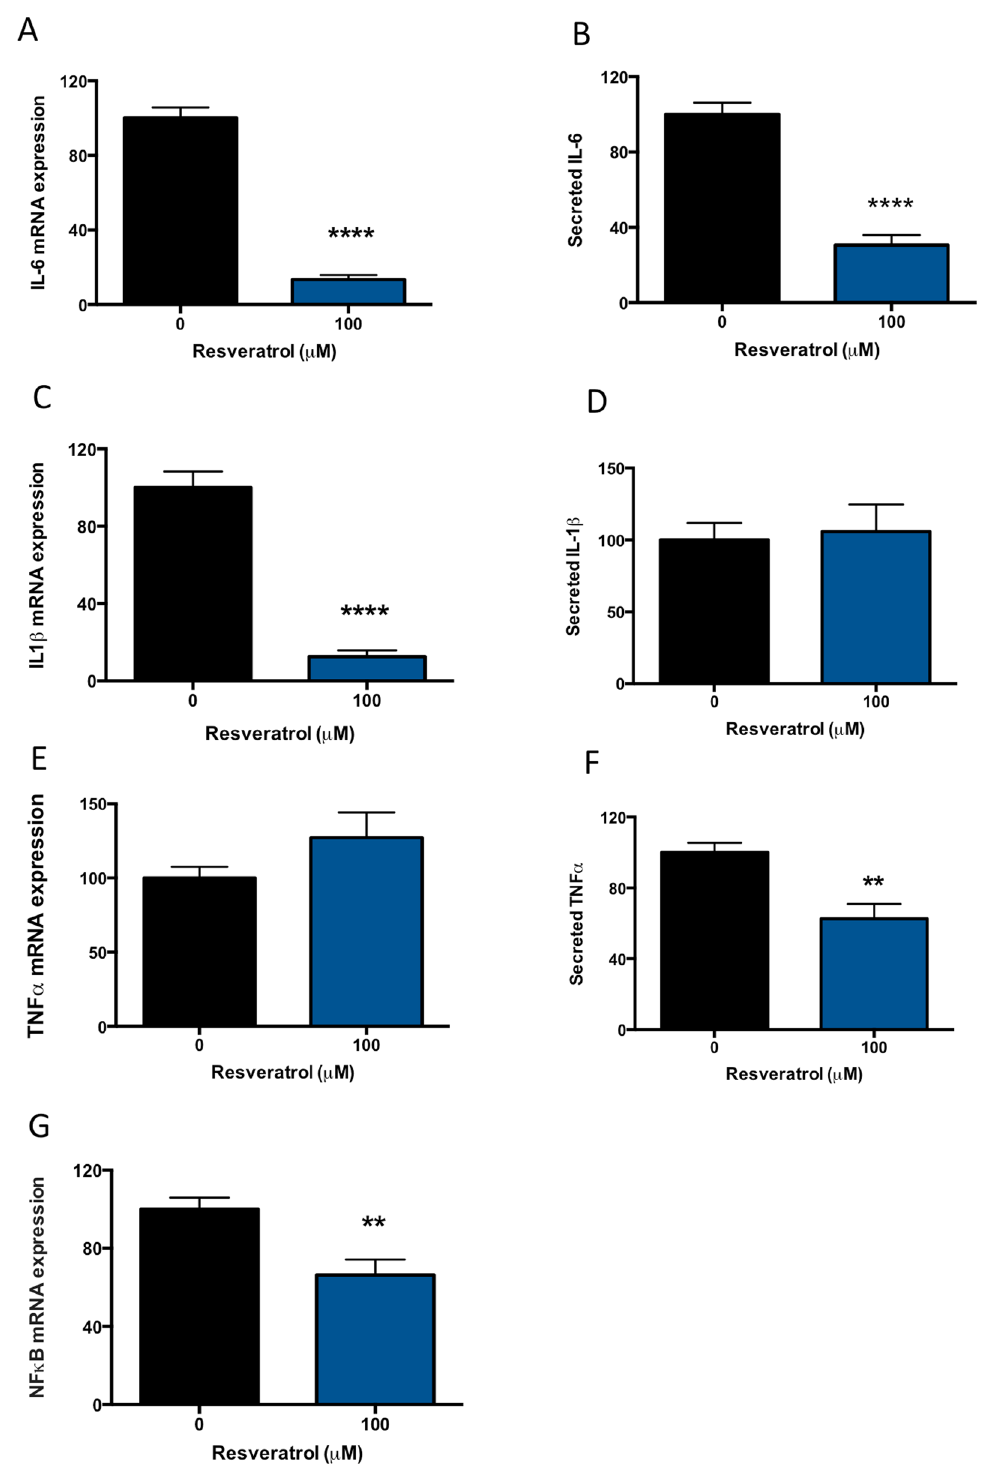
Figure 4. Resveratrol inhibits inflammatory molecules in primary cytotrophoblast. Preeclampsia is a condition associated with significant inflammation. Therefore we assessed the ability for resveratrol to reduce pro- inflammatory cytokine mRNA expression and secretion. In primary trophoblast, we found that resveratrol significantly reduced ( A ) IL-6 mRNA and ( B ) protein secretion. Whilst resveratrol significantly reduced ( C ) IL-1 β mRNA expression, there was no significant effect on IL-1 β secretion ( D ). TNF α mRNA expression was not altered by resveratrol ( E ), however secreted TNF α was significantly reduced ( F ). Finally a significant reduction in ( G) NF κ B mRNA expression was also significantly reduced. Data expressed as mean ± SEM. ** p < 0.01, **** p < 0.0001 compared to 0 resveratrol (control). N = 3–5 experimental replicates, with each n taken from a separate patient